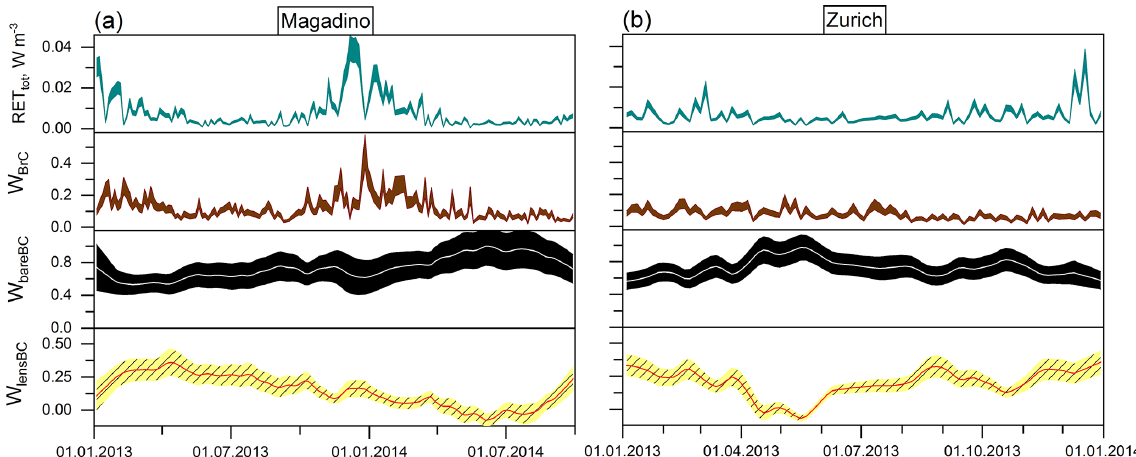
Figure 9. Time series of the extractable Mie-predicted particulate BrC (brown), bare BC (black) and filter-based BC lensing (sparse light yellow) fractional contributions ( W ) to the rate of energy transfer per volume due to light absorption by total carbonaceous aerosol (RET tot ; dark cyan) upon integration of the respective absorption spectra with the solar radiation spectrum at 300–900nm (Eq. D1) for Magadino (a) and Zurich (b) . Contributions are shown as surfaces indicating propagated errors covering the full range upon integration. Contributions by bare BC and lensing were smoothed for demonstration (central estimates are shown as white and red lines, respectively).